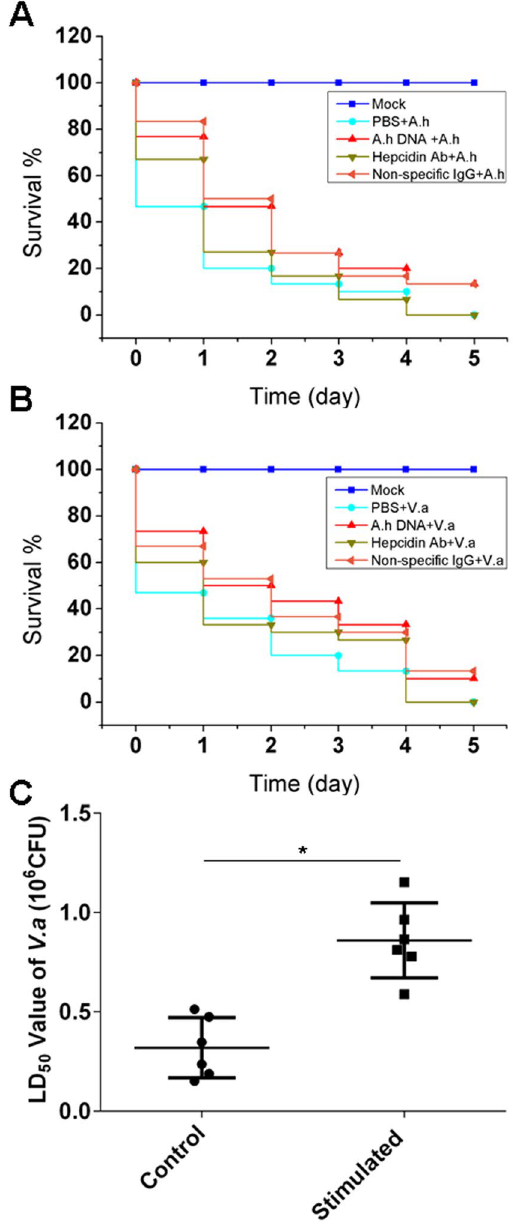
Figure 5. In vivo immunoprotection assay of hepcidin-mediated antibacterial activity. ( A ) The survival rate of zebrafish upon A. hydrophila ( A.h ) infection (2.1 × 10 5 CFU per fish). The fish received various treatments before infection, including stimulation with A. hydrophila DNA (1.5 μ g per fish, indicated as A.h DNA + A.h ), administration of anti-hepcidin Ab for hepcidin neutralization (indicated as Hepcidin Ab + A.h ), in which the non-specific rabbit IgG was administrated into the A. hydrophila DNA stimulated fish as a negative control (indicated as Non-specific IgG + A.h ), and administration of mock PBS into the non-stimulated control fish (indicated as PBS + A.h ). ( B ) The survival rate of zebrafish upon V. alginolyticus ( V.a ) infection (2.9 × 10 5 CFU per fish). The fish received various treatments before infection similar to that as described in Fig. 5A. The Mock fish (indicated as Mock in Fig. 5A and B) received only A . hydrophila DNA without infections. ( C ) Immunoprotective effect of hepcidin-mediated antibacterial immunity against V. alginolyticus infection determined by the alteration of lethal dose 50 (LD 50 ) of V. alginolyticus that kills 50% of the test fish within a set amount of time (24 h). The control fish (indicated as Control) received only PBS before infections. The stimulated fish (indicated as Stimulated) received A . hydrophila DNA (1.5 μ g per fish). At least 30 fish were used in each experimental group, and all data are representative of at least three independent experiments. * p <